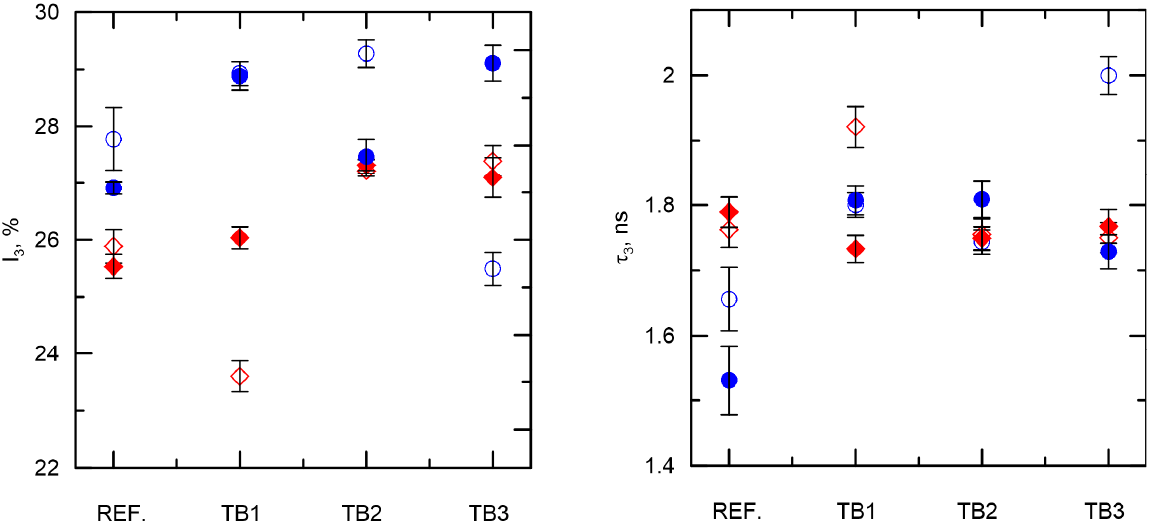
Figure 5. The o-Ps intensity (I 3 ) and lifetime ( τ 3 ) for reference and samples with different photo- catalysts during removal of Met (dots) and Pro (diamonds) in darkness (empty points) and light (full points).